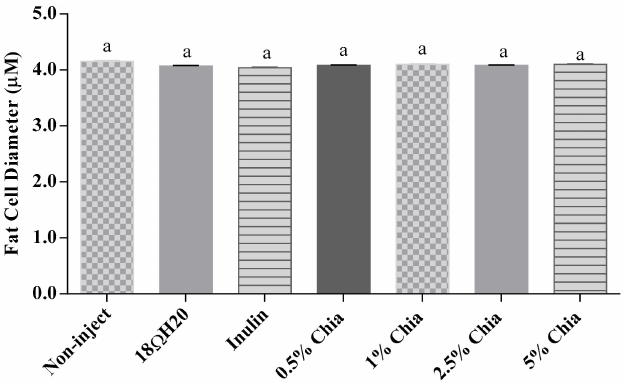
Figure 4. Representations of the intestinal morphology of each treatment group are shown (Alcian Blue and Periodic acid-Schi ff Stain). The yellow circles indicate crypts within the villi and the red circles indicate goblet cells on the villi. Bar = 50 µ m.